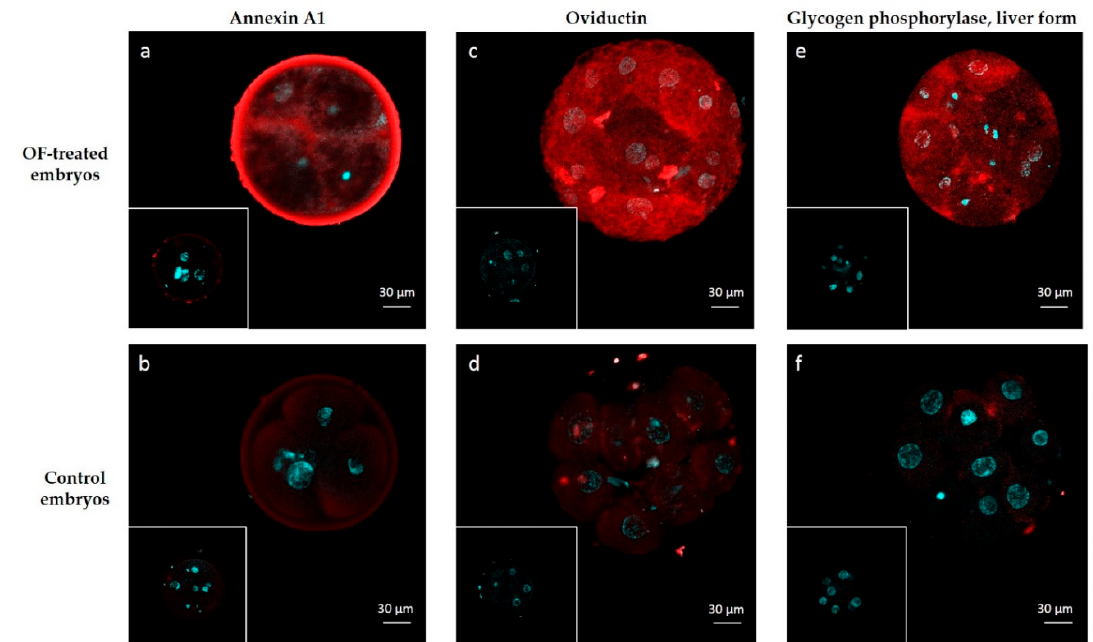
Figure 4. Immunolocalization of embryo-interacting proteins in OF-treated embryos ( a , c , e ) and controls ( b , d , f ). Proteins of interest are in red and nuclei are in blue. Embryos were incubated with anti-ANXA1 ( a , b ), anti-OVGP1 ( c , d ) and anti-PYGL ( d , e ). Inserts: controls with isotypes instead of primary antibodies.